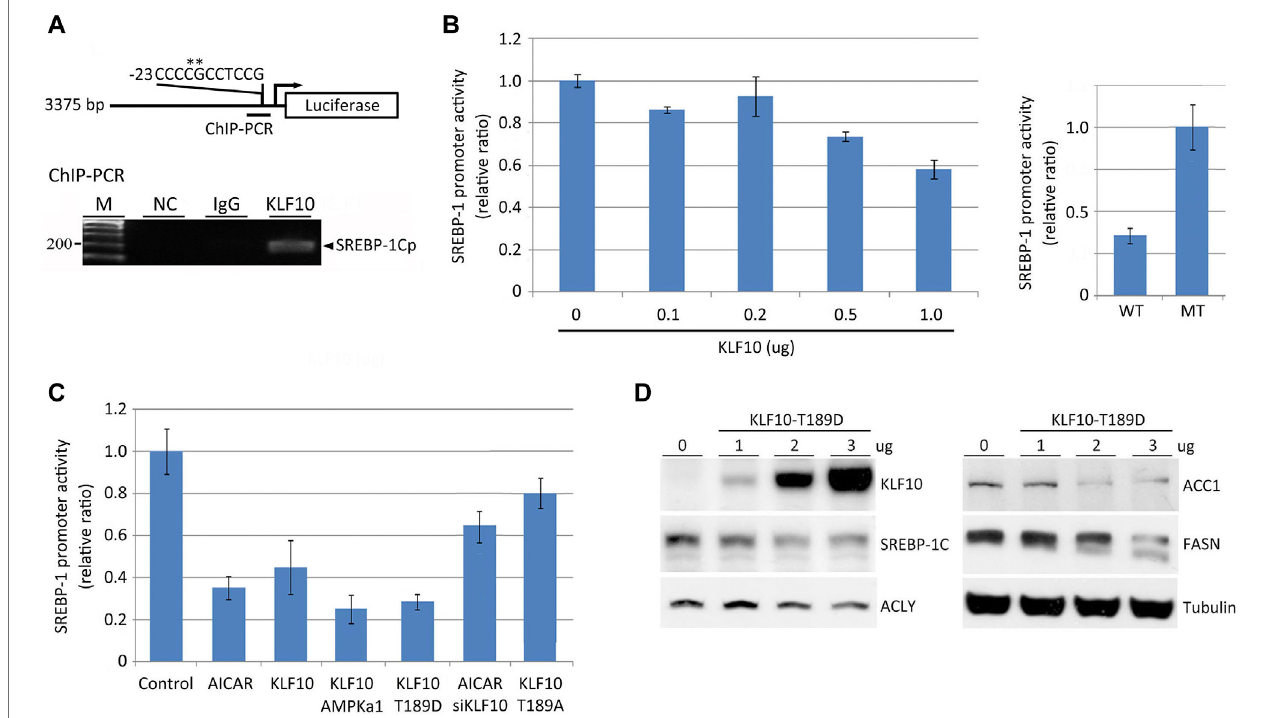
FIGURE 3 | KLF10 modulates SREBP-1C promoter activity via direct binding. (A) A diagram of the cloned 3.3-kb human SREBP-1C promoter showing the SP/ KLF binding site from positions − 13 to − 23. An expression plasmid encoding KLF10 and the SREBP-1 promoter luciferase reporter, the latter with (MT) or without (WT) site-directed mutagenesis, was transfected into HepG2 cells to conduct transcriptional reporter assays. (B) HepG2 cells were individually transfected with a wild-type SREBP-1C promoter – luciferase construct with or without a KLF10-overexpressing construct (0.1 – 1.0 μ g) for 12 h. Cellular extracts were used to measure luciferase activity and normalized against Renilla luciferase activity. Data are represented as the mean ± SD (n ≥ 3). In the right panel, wild-type or site-directed mutant constructs of the SREBP-1C promoter were transfected into HepG2 cells co-transfected with KLF10 (1.0 μ g) and the luciferase activity was detected. (C) The quanti fi cationoftranscriptlevelsofSREBP-1CafterHepG2cellstreatedwithAICARortransfectedwithKLF10,AMPK,mutantKLF10constructs(T189DandT189A),or siKLF10. (D) The expression of KLF10, SREBP-1C, ACLY, ACC1, and FASN were detected after transfected with KLF10-189D mutant for 48 h. Tubulin was used as a loading